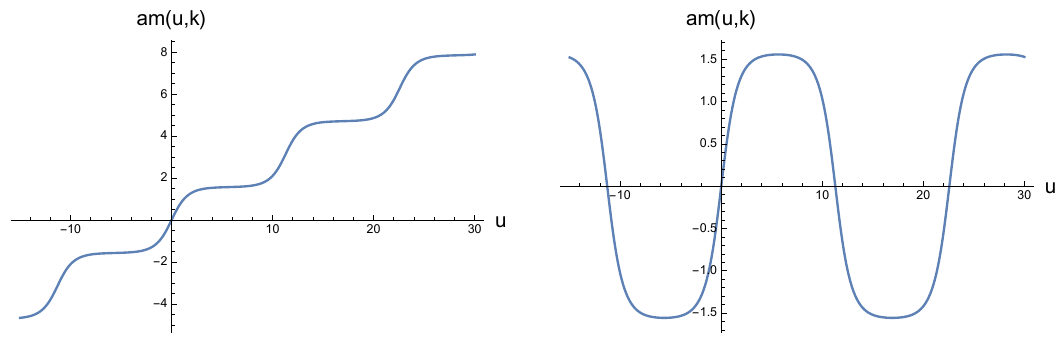
Figure 13 . The Jacobi amplitude am( u, k ) . The parameter k is chosen as k = 0 . 9999 in the left plot, and k = 1 . 0001 in the right